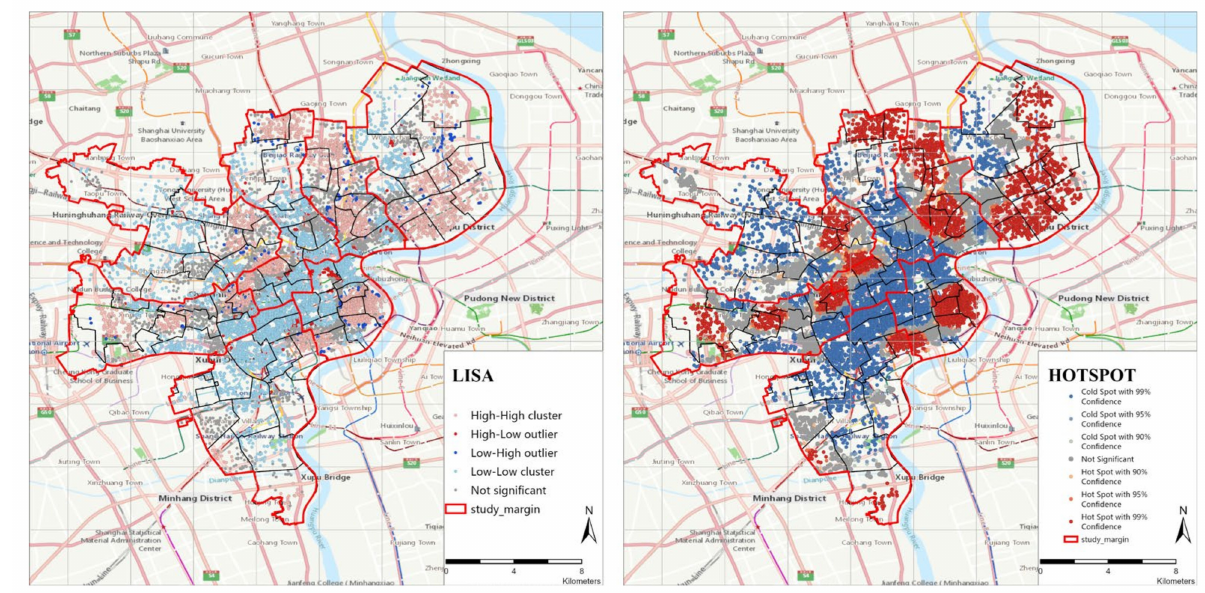
Figure 10. Local autocorrelation analysis of Category − II (LISA, Getis-Ord